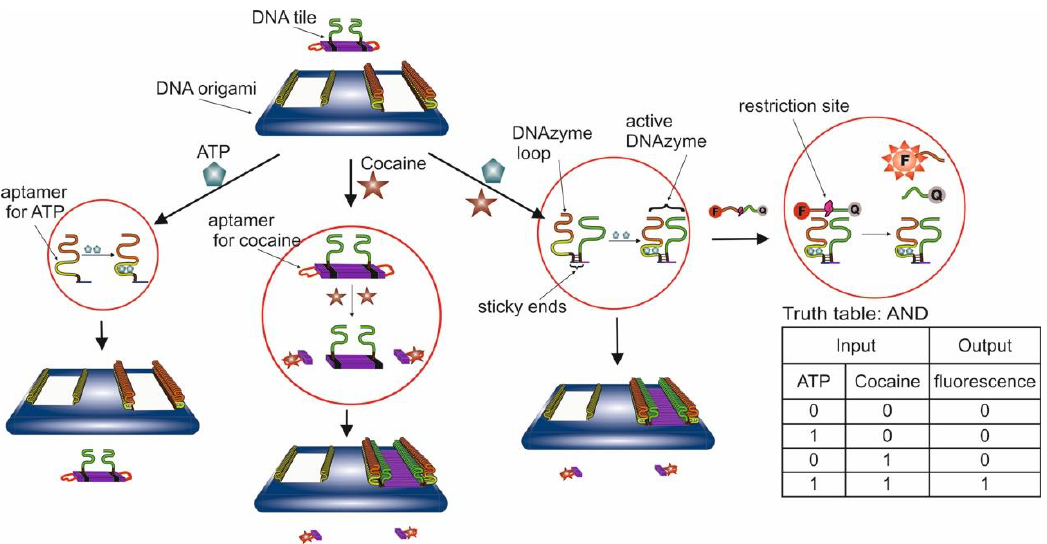
Figure 21. The AND logic gate. ATP = adenosine triphosphate, F = fluorescent label, Q = quencher label. Adapted from Reference [161]. Copyright © 2020, American Chemical Society.